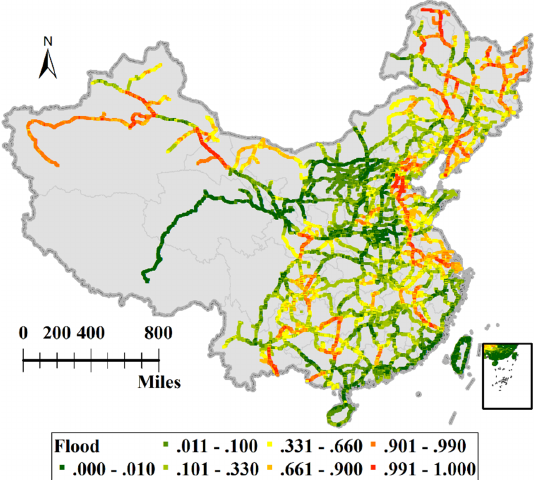
Figure A8. Susceptibility map of the national railway network sub- jected to flood (source: Liu et al.,